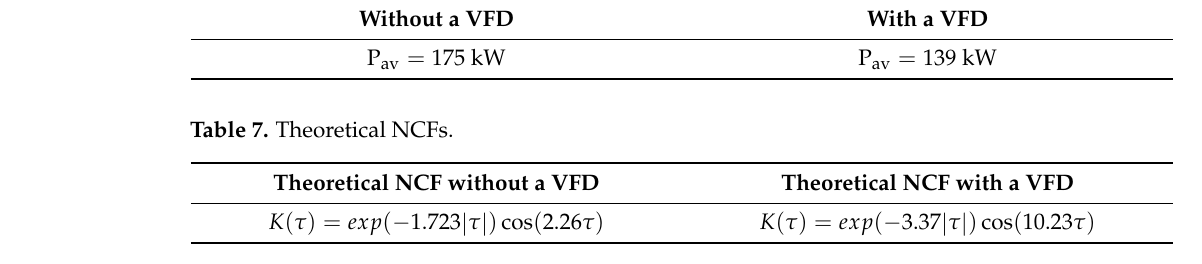
Table 6. Approximate average power values. Figure 2. Fragment of the curve of active power consumption with a VFD.